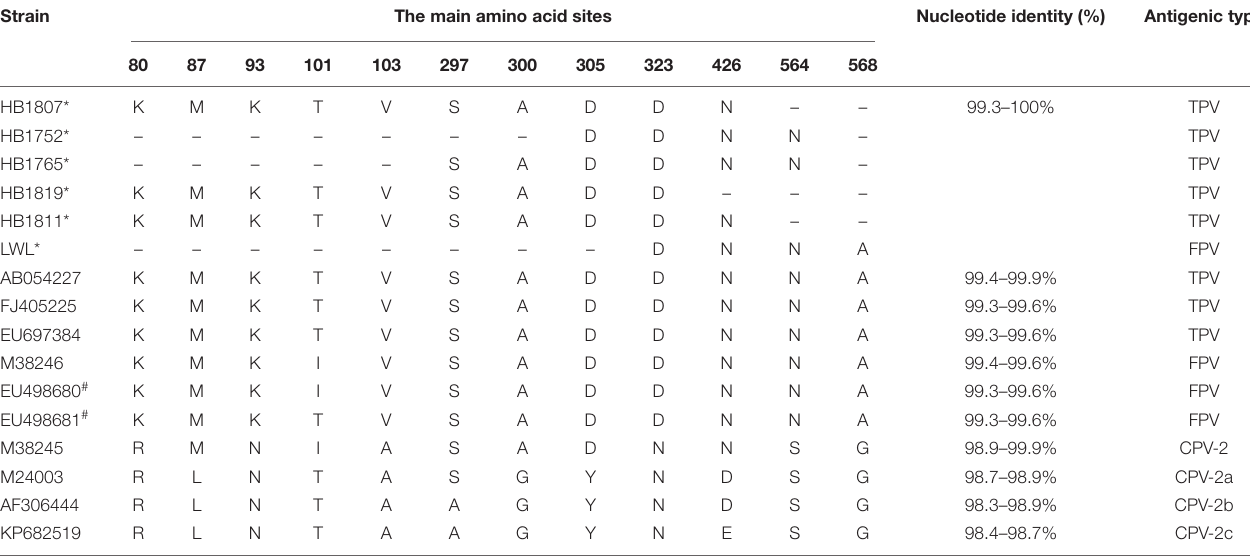
TABLE 2 | Amino acid residues characteristic and pairwise identity of VP2 in this study compared with other related parvovirus strains.